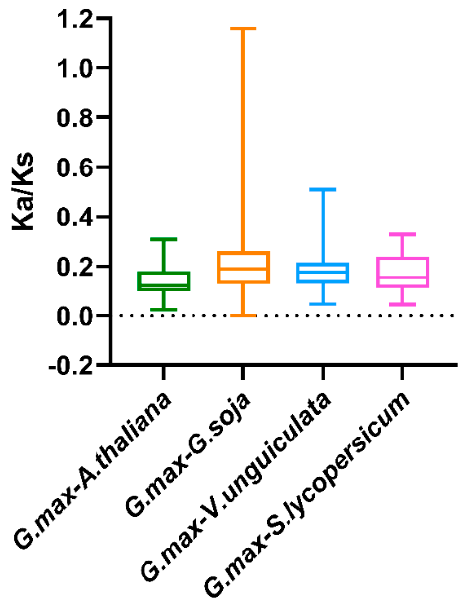
Figure 6. Box plot for the ratios of nonsynonymous to synonymous substitutions (Ka/Ks) in orthologous TALE gene pairs. The species names with the prefixes ‘ G. max ’, ‘ A. thaliana ’, ‘ G. soja ’, ‘ V. unguiculata ’ and ‘ S. lycopersicum ’ indicate Glycine max , Arabidopsis thaliana , Glycine soja , Vigna unguiculate and Solanum lycopersicum , respectively.